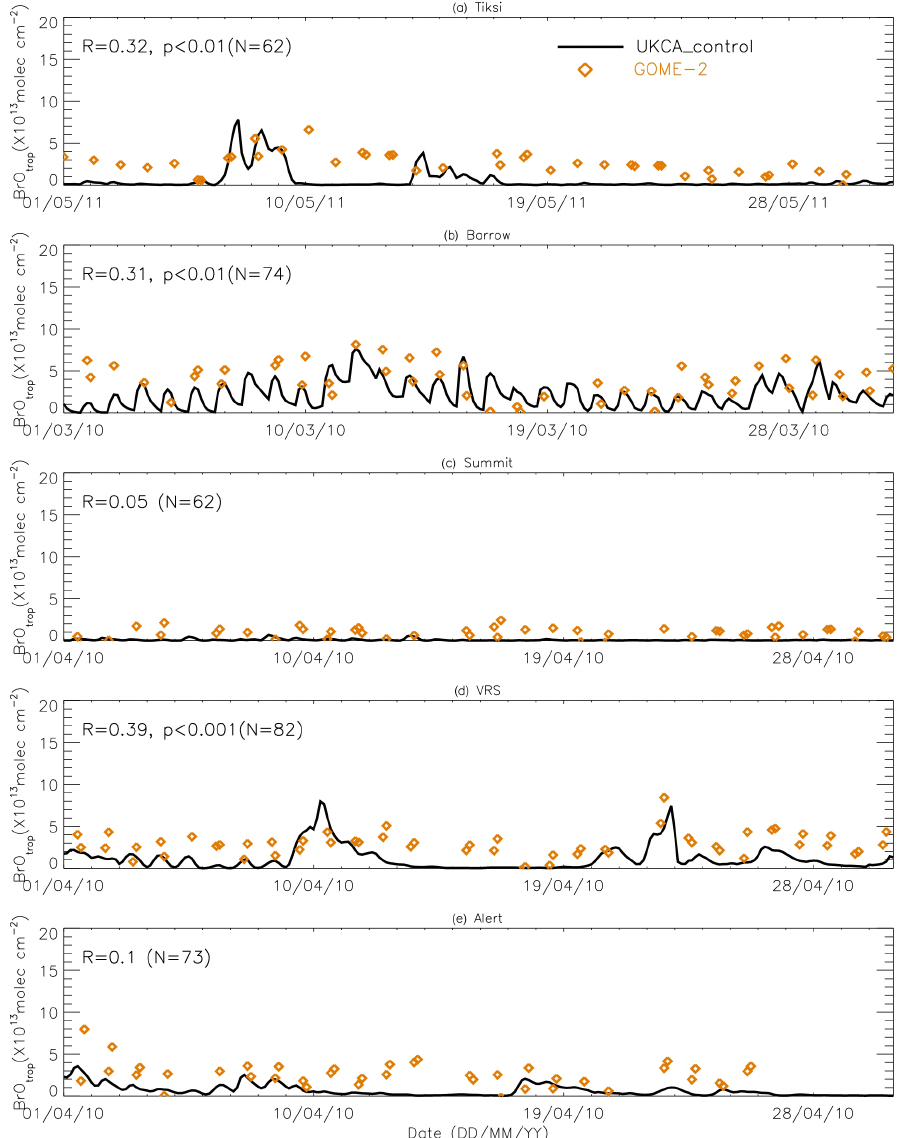
Figure 10. Same as Fig. 9 but for UKCA_control run